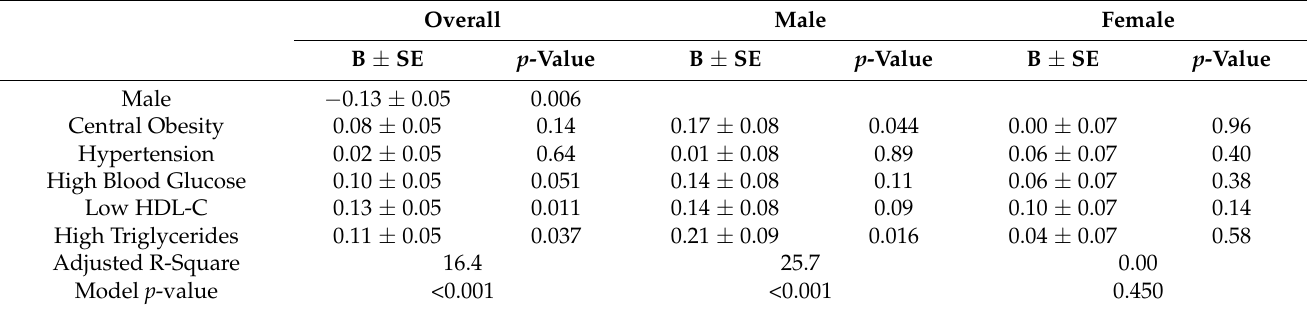
Table 3. Relationship between MetS components and TTP among males and females. Overall Male